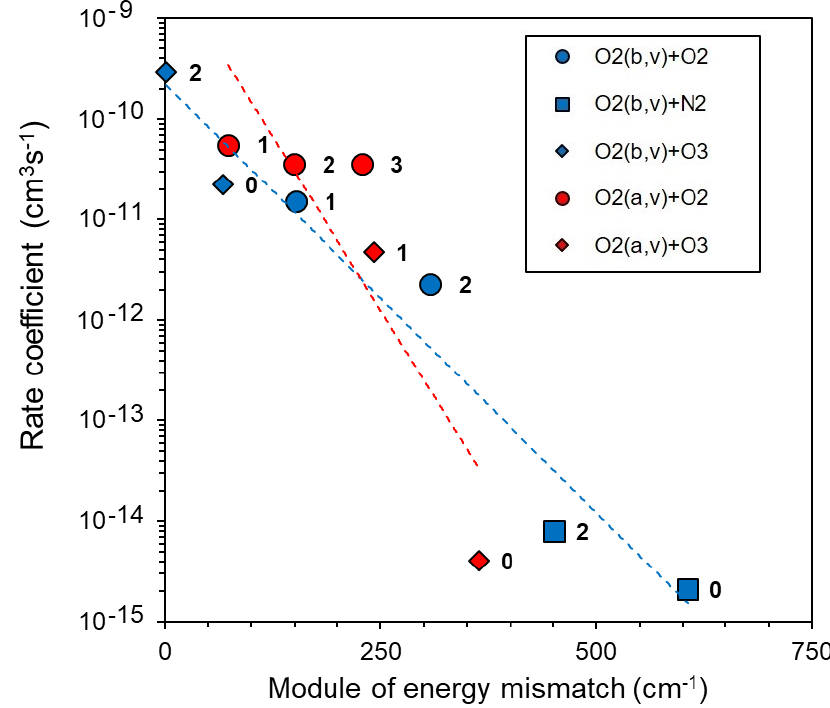
Figure 5. The same as Figure 4 but for O 2 (b 1 Σ g + , v) + O 2 → products (blue circles), O 2 (b 1 Σ g + , v) + N 2 → products (blue squares), O 2 (b 1 Σ g + , v) + O 3 → products (blue diamonds), O 2 (a 1 ∆ g , v) + O 2 → products (red circles), O 2 (a 1 Δ g , v) + O 3 → products (red diamonds) [2].